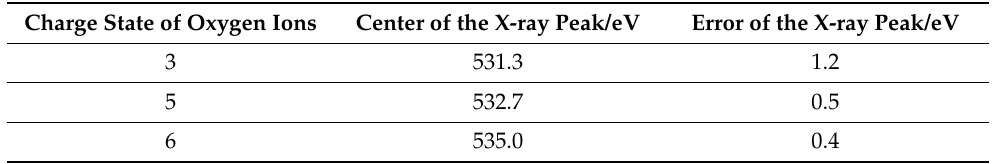
Table 1. Gauss fitting results to the measured X-ray spectra for 10 keV/q oxygen ions with charge state, q, equal to 3, 5, and 6,